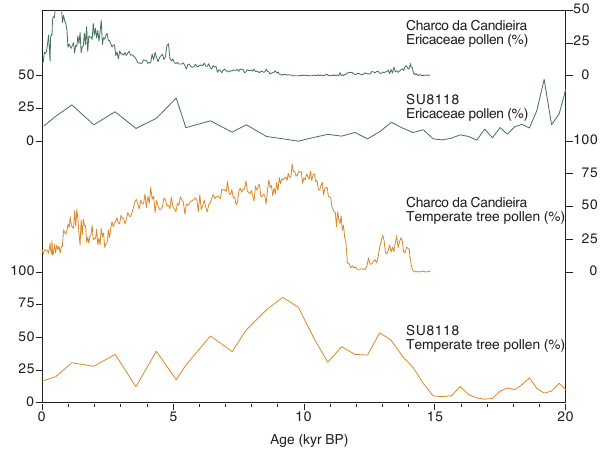
Fig. 4. Comparison of Lateglacial/Holocene changes in temperate tree (Eurosiberian and mediterranean taxa) (orange) and heathland (Ericaceae) (green) pollen percentages in deep-sea core SU8118 on the SW Portuguese margin (Turon et al., 2003) and at Charco da Candieira in the Serra da Estrella mountain range in Portugal (van der Knaap and van Leeuwen, 1995, 1997), plotted on their respec- tive timescales. Note that the record from Charco da Candieira cov- ers only the last ∼